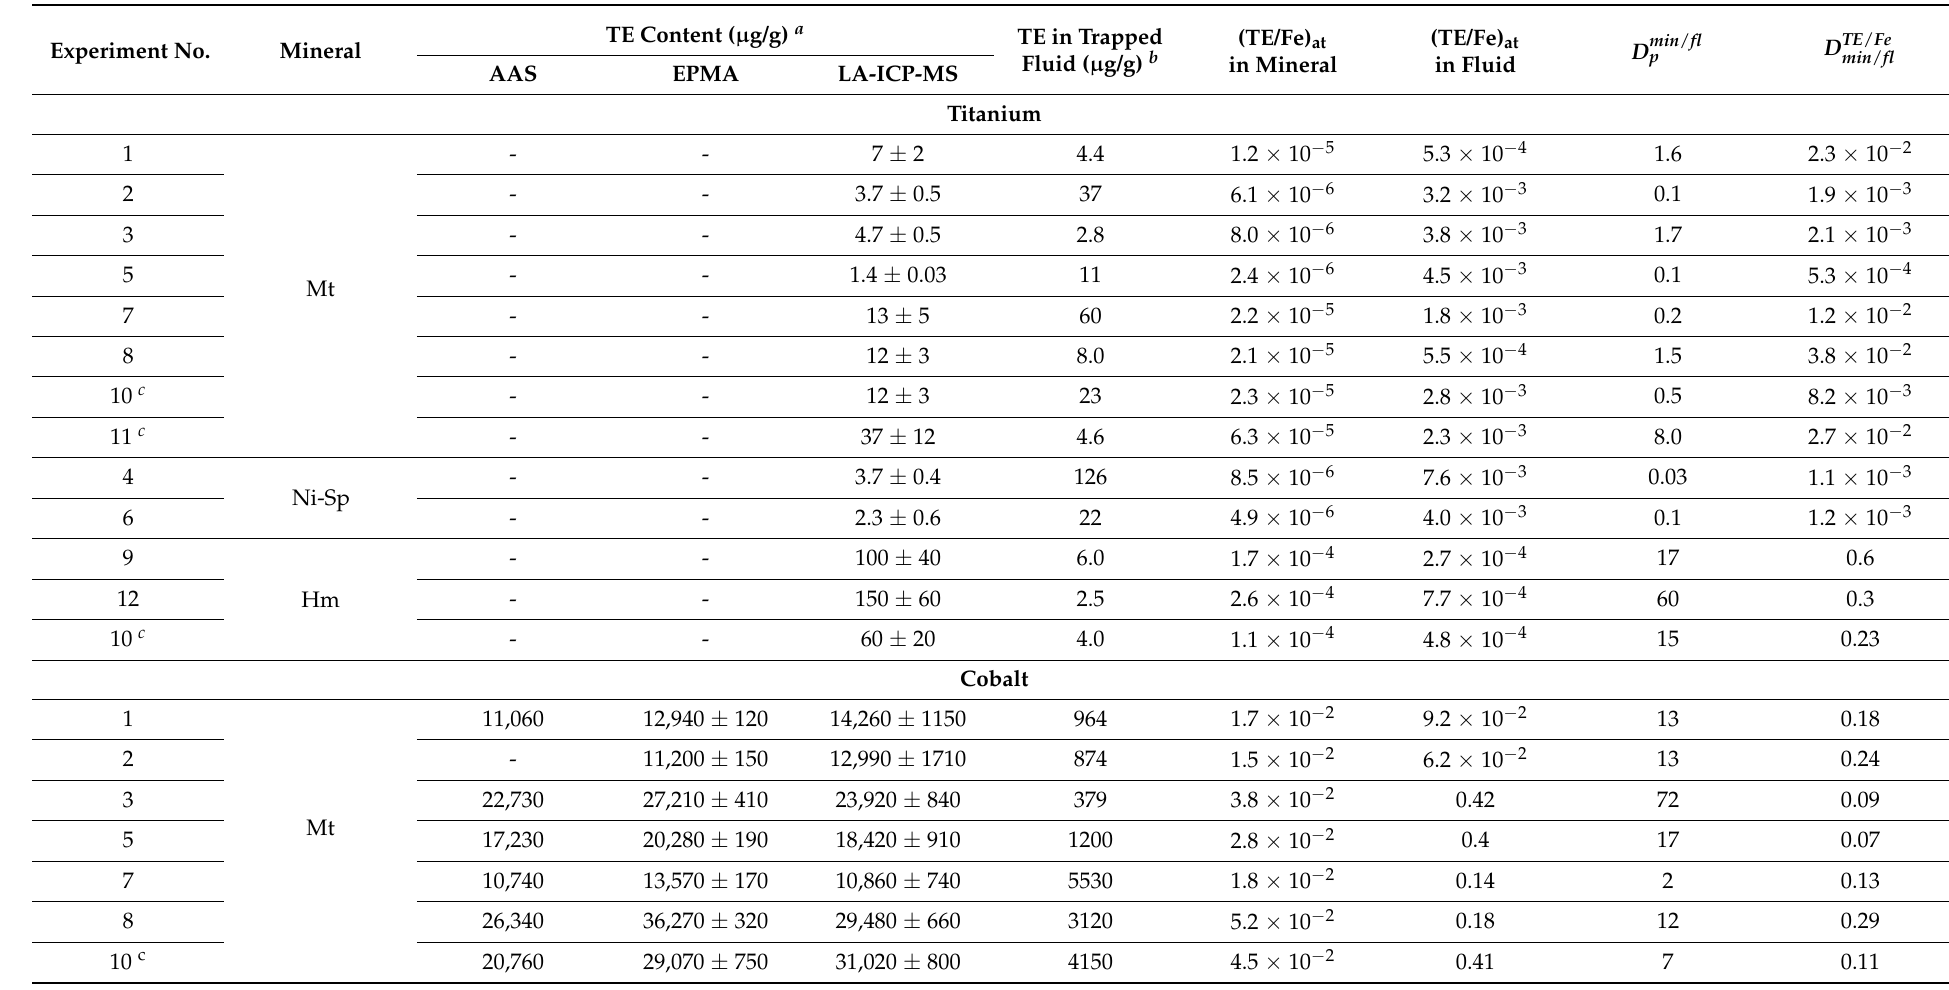
Table A1. Compositions of obtained crystals, trapped fluids and calculated partition and co-crystallisation coefficients of trace elements in the mineral–hydrothermal fluid system at 450 ◦ C and 1 kbar. Experiment